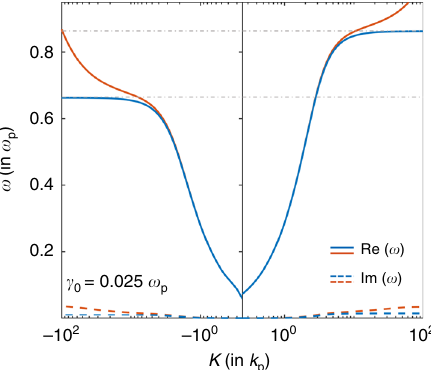
Fig. 4 Dispersion relations in the real-wavevector complex-frequency picture. The dispersion relations in the real wavevector and complex- frequency picture for the surface-plasmon polariton in the local Drude model (blue) is contrasted with that in the hydrodynamic model (red). The solid and dotted lines represent the real and imaginary parts of the frequency, respectively, for a loss rate of γ 0 = 0.025 ω p . In the local model, the fl at asymptote in the limit of K → ∞ persists even upon the inclusion of losses, resulting in an in fi nite number of states. By contrast, in the hydrodynamic model, the unidirectional frequency gap is closed in the real- wavevector complex-frequency picture as well as the complex-wavevector real-frequency picture (shown in Fig. ( E × H * , red curve) and the kinetic energy of the free carriers ( J (cid:4) ∇ (cid:3) J ð Þ , yellow curve), unlike in the local model. Since there is a PEC termination, the total Poynting vector to the right of the source must be zero. We see that this is indeed the case, with the forward propagating electromagnetic component being canceled exactly by the counter-propagating kinetic component, an effect arising from the nonlocal term J * ( ∇ ⋅ J ). Similarly, a negative value of Poynting fl ux is observed to the left of the source, also con fi rming the excitation of the high- K mode propagating backward.